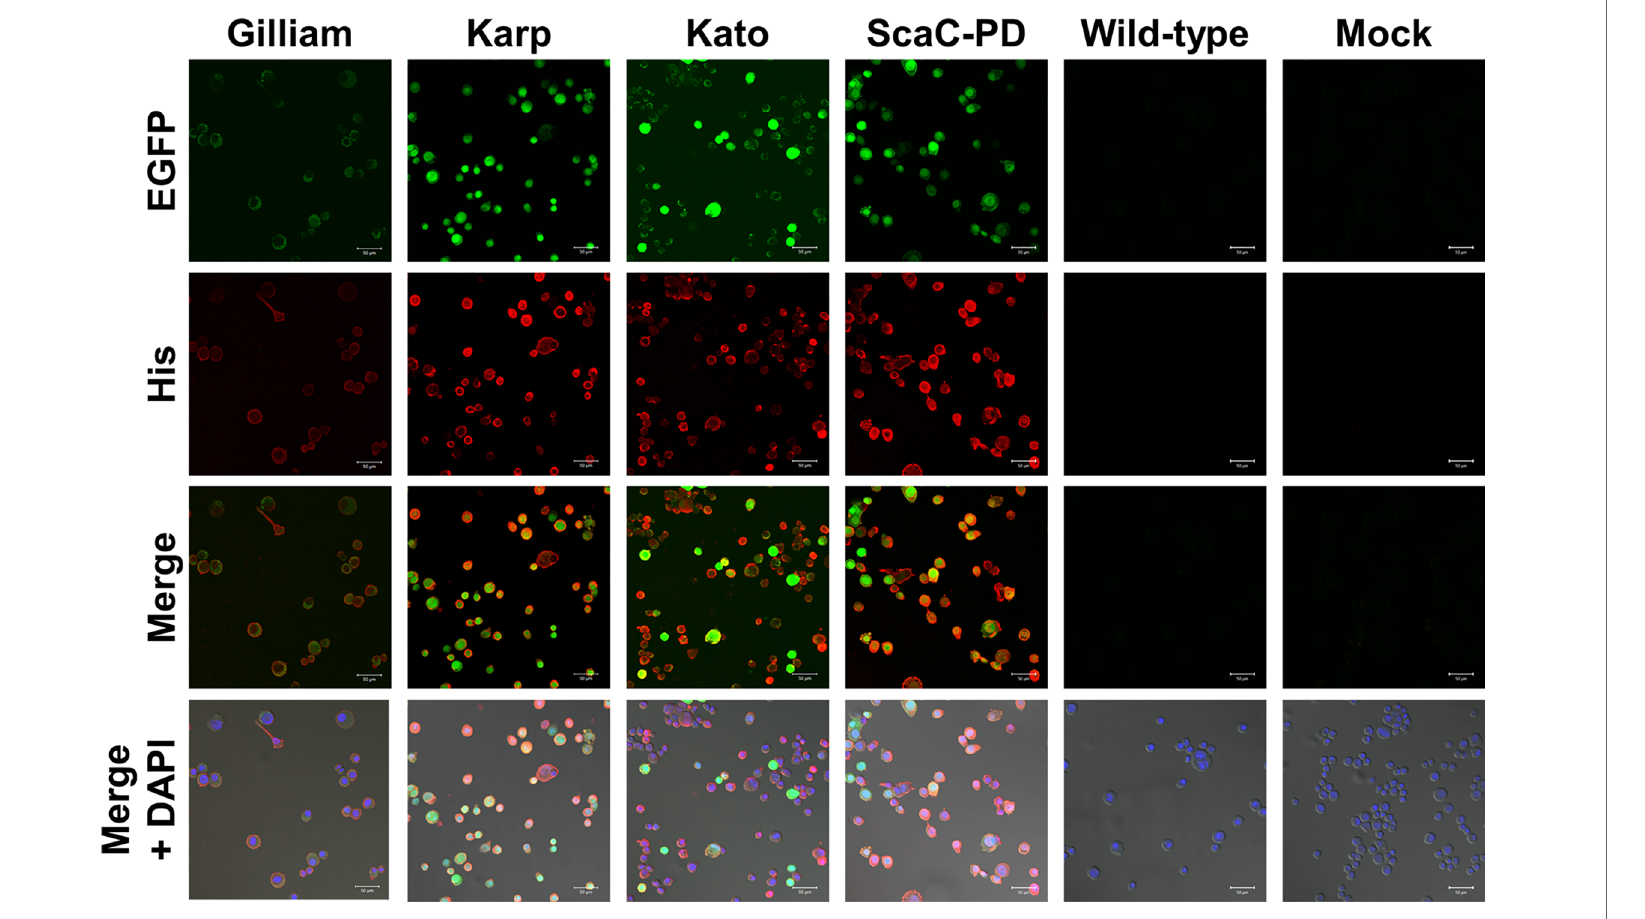
FIGURE 4 | Immuno fl uorescence assay to con fi rm surface display of target proteins by Sf21 cells. Sf21 cells infected with recombinant baculoviruses carrying TSA56 or ScaC-PD gene constructs emitted green fl uorescence arising from co-expression of the EGFP reporter gene. Cell surface display of recombinant TSA56 or ScaC-PD by the Sf21 cells was examined by immunostaining using primary anti-His antibody and secondary Alexa Fluor 555 antibody (red fl uorescence). DAPI: nuclear counterstain (blue fl uorescence). Wild-type: cells infected with wild-type baculovirus. Mock: cells not subjected to virus infection. Scale bar: 50 m